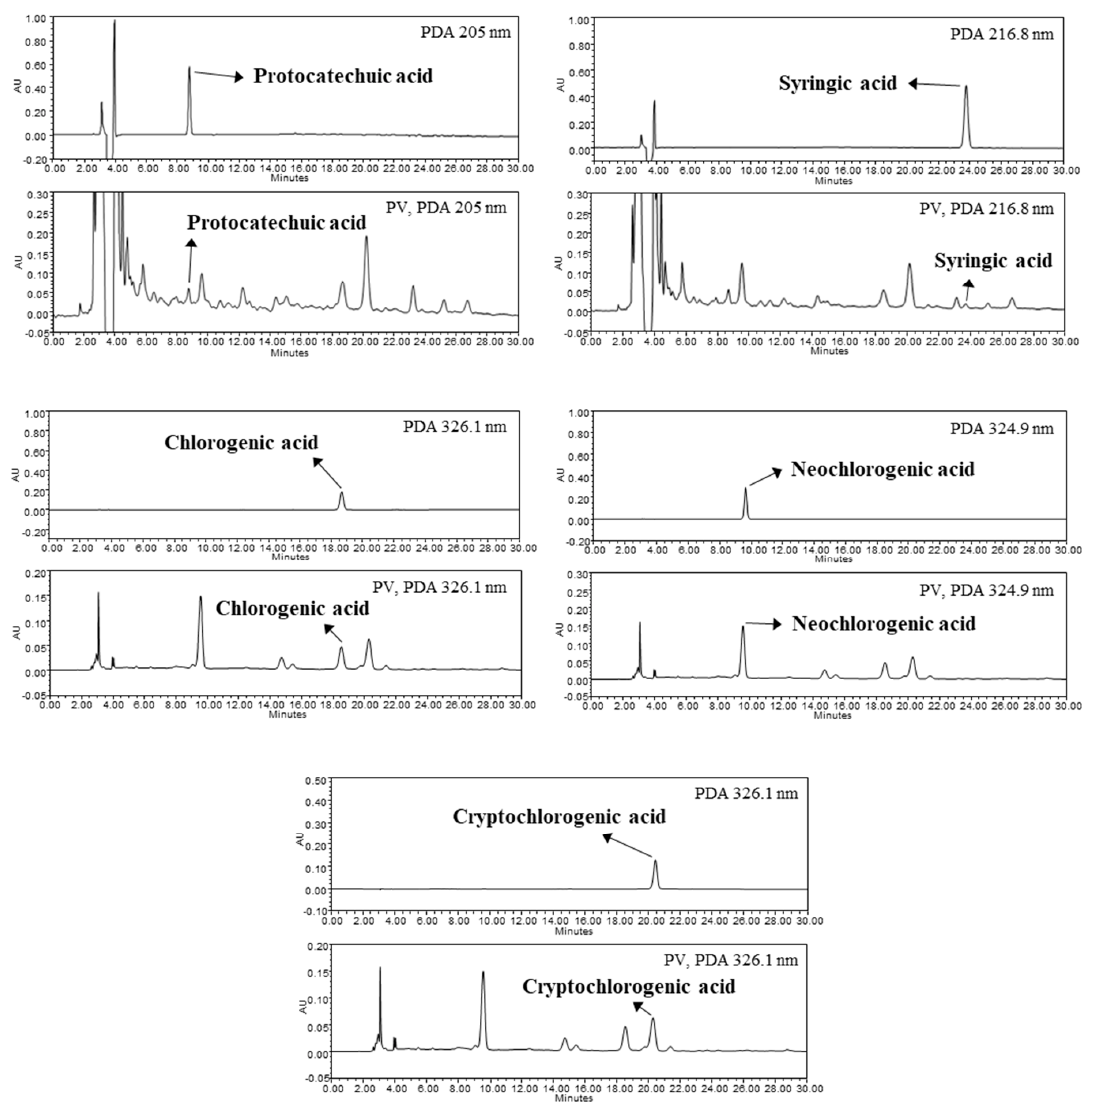
Figure 1. Phenolic compounds in Prunus mume vinegar (PV) analyzed by HPLC. Protocatechuic acid (205 nm, 8.774 min); syringic acid (216.8 nm, 23.857 min); chlorogenic acid (326.1 nm, 18.663 min); neochlorogenic acid (324.9 nm, 9.660 min); cryptochlorogenic acid (326.1 nm, 20.395 min).